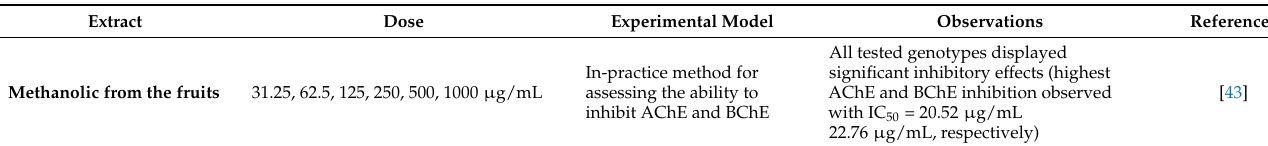
Table 9. The anticholinesterase effects of Ziziphus nummularia .